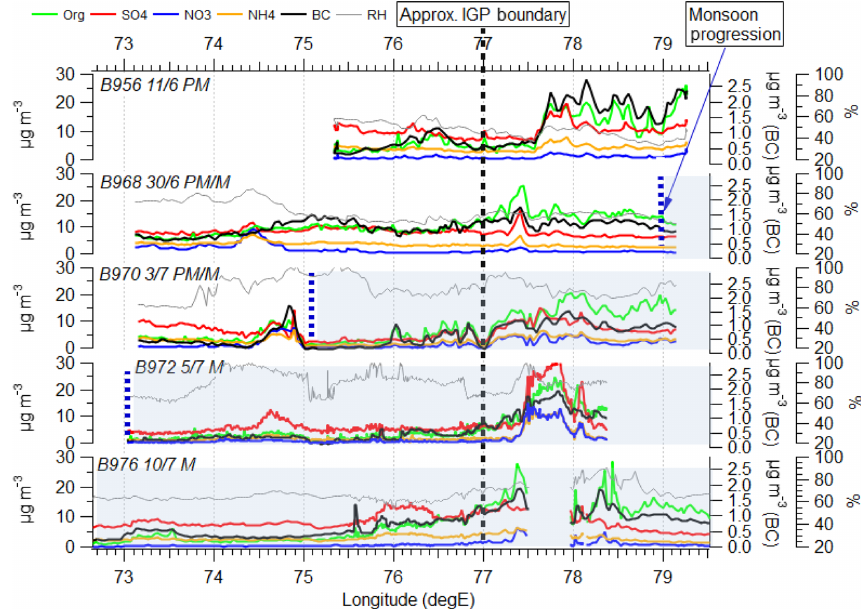
Figure 6. Horizontal spatial aerosol chemical composition (below 1000m) plots for pre-monsoon (PM) and monsoon (M) seasons in northern India, from Lucknow to Jaipur/Jodhpur. The plots highlight the IGP region (77 ◦ E eastwards) and the outside of the IGP (73–77 ◦ E) separated by the vertical black dashed line. The monsoon progression is indicated by the blue shaded region.